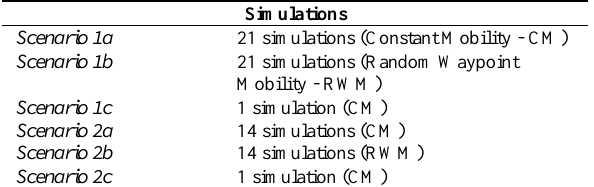
Table 5. Overview of the overall simulations.